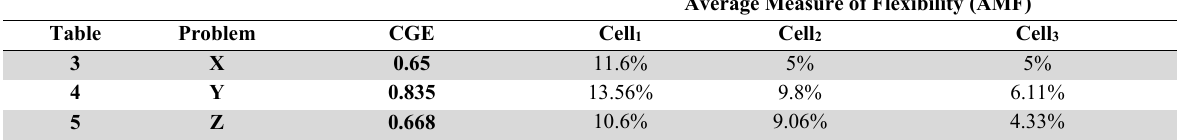
Efficiency of the system and average measure of flexibility using CGE for